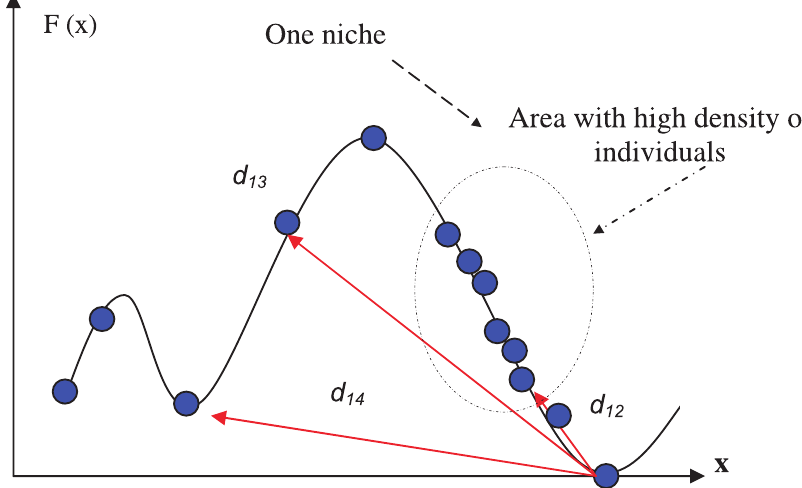
Fig. 6. Description of the relative distance with the sharing